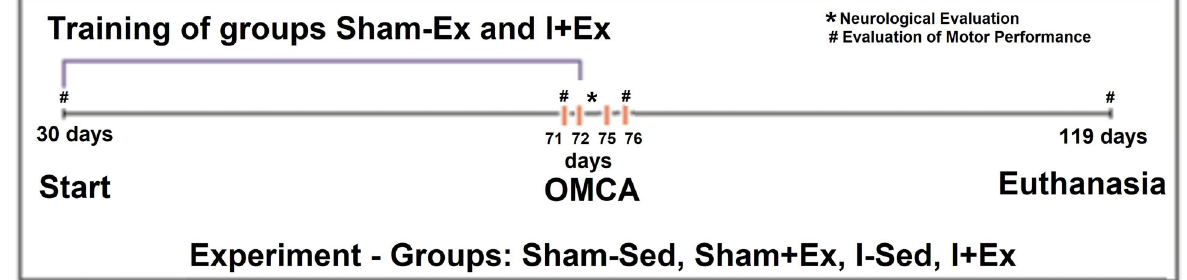
Figure 1. Design of experiment I, highlighting the main procedures conducted. At 30, 71, 76, and 119 days, motor performance was evaluated. At 72 days, occlusion of the middle cerebral artery (OMCA) was performed. The neurological evaluation was performed during the period of three days - 72 to 75 days. Sham-Sed: Sedentary control group; Sham + Ex: Control group exercised before the sham surgery; I-Sed: Sedentary ischemic group; I + Ex: Ischemic group exercised before OMCA